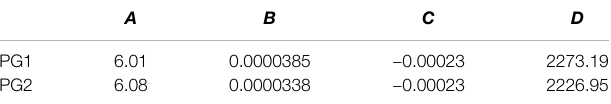
TABLE 2 | Regression coef fi cients A (dbar), B (d − 1 ), C (dbar d − 1 ), and D (dbar) for the exponential and linear functions to estimate the sensor drift component ( p d ) of the detided daily PSF data at PG1 and PG2. p d is represented by the